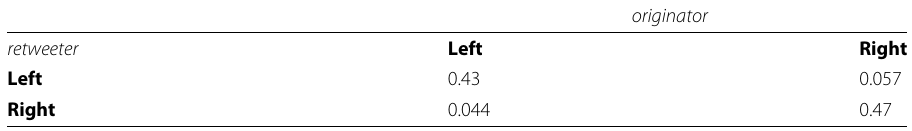
Table 3 Mixing matrix E of the edges between the types of accounts. We characterize the type of an account by the sign of its media PCA score originator retweeter Left Right Left 0.43 0.057 Right 0.044 0.47 As usual, ‘Left’ indicates a negative media PCA score, and ‘Right’ indicates a positive media PCA score. (No nodes have a media PCAscoreofexactly0.)Accountstendtomixwith(specifically,beadjacentto)accountswithamediaPCAscoreofthesamesign, as indicated by the larger values on the diagonal of the mixing